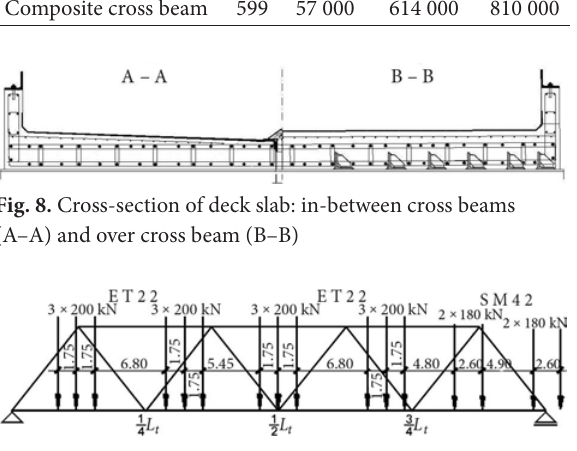
Fig. 9. Analysed test loading scheme with locomotive set